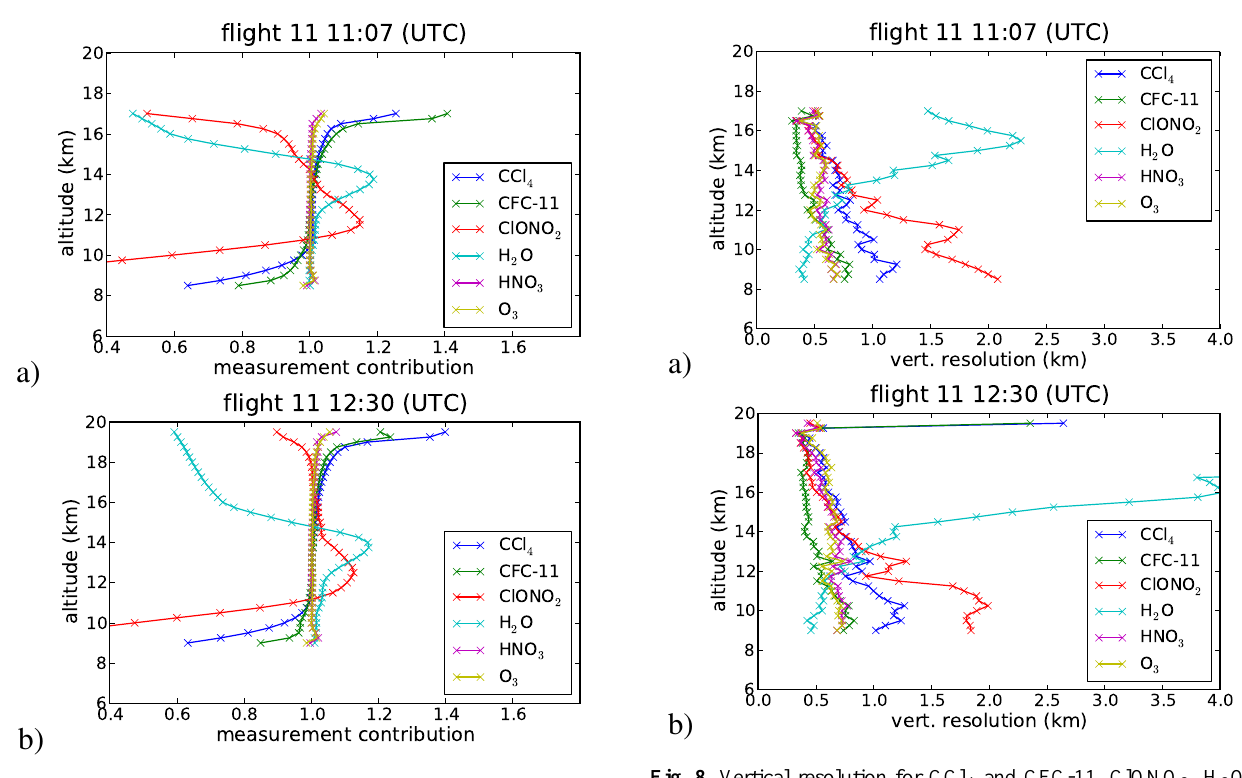
and CFC-11, ClONO 4 and CFC-11, 4